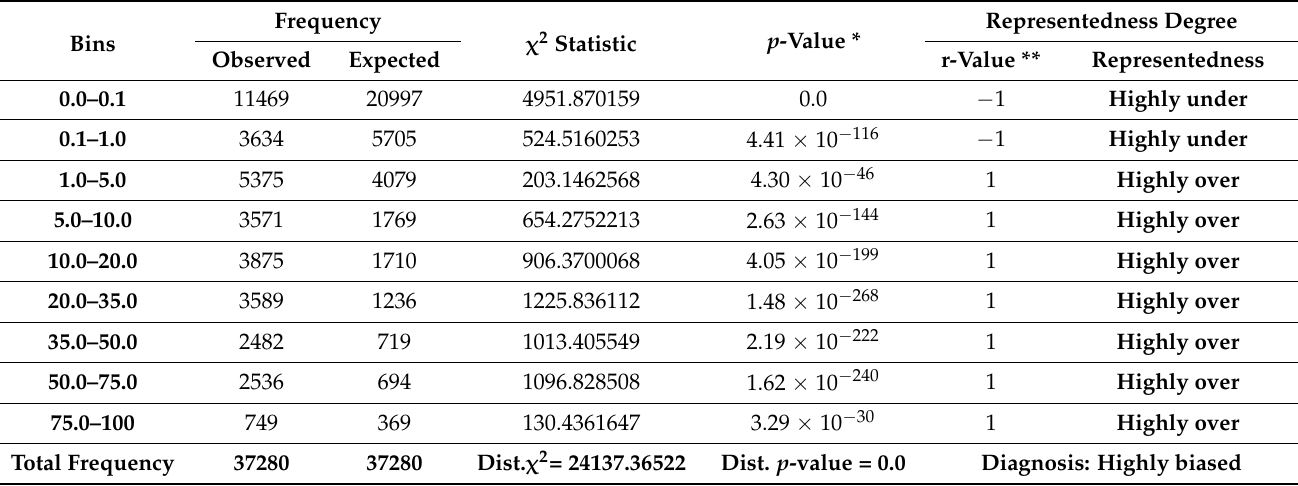
Table 3. Pearson’s χ 2 test results with percentage of area equipped for irrigation variable.